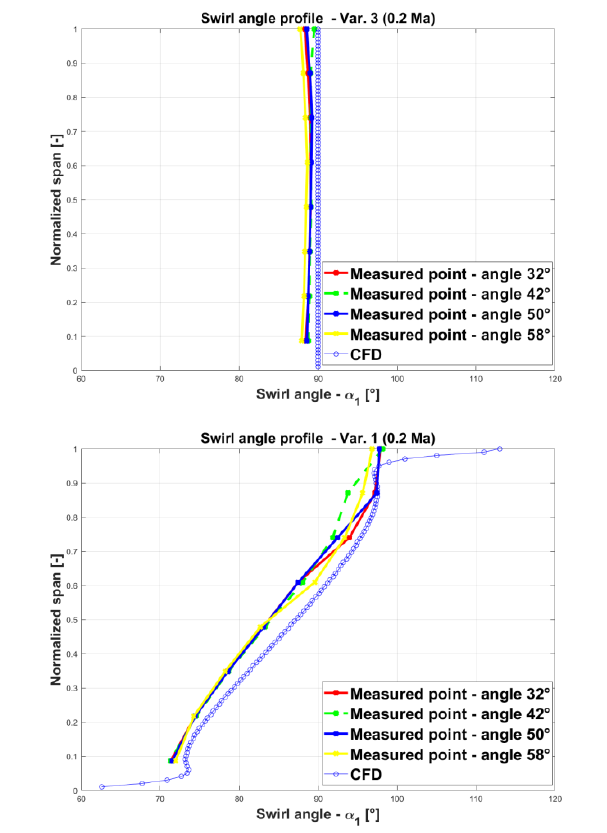
Fig. 11. Profile of swirl angle 𝛼 1 along the channel